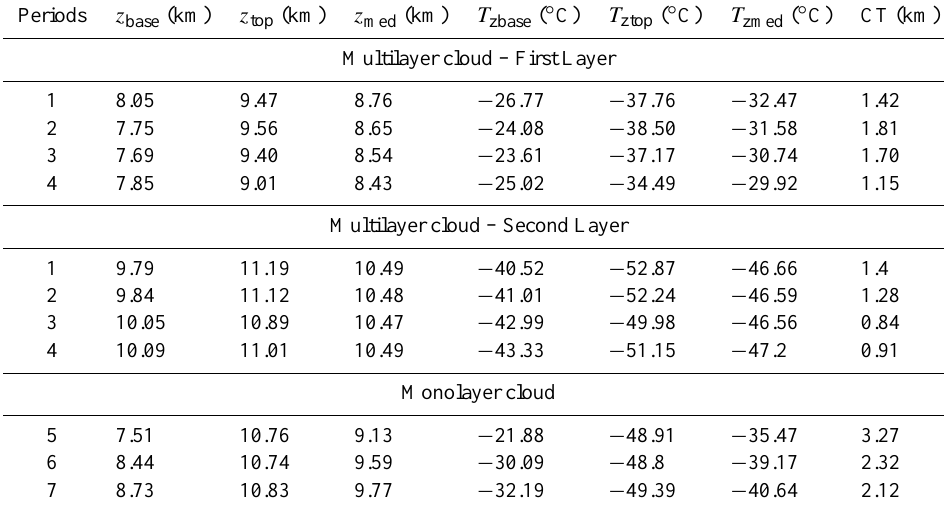
Table 1. Macrophysical properties of cirrus observed over São Paulo City on 11 June 2007. Periods z base (km)